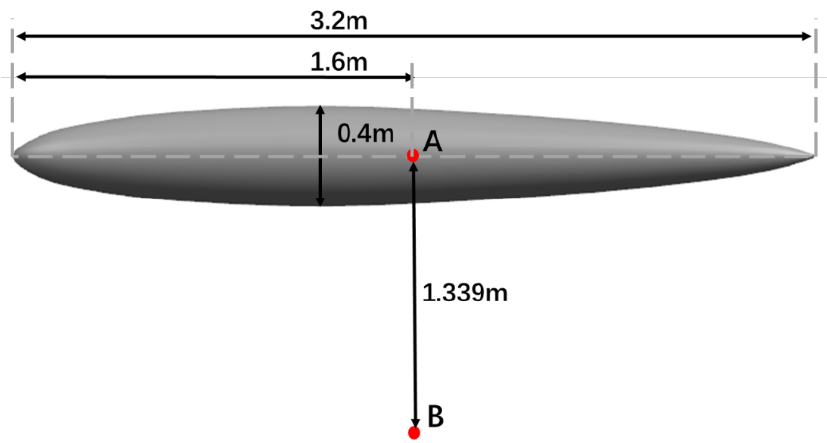
Figure 1. Geometry of the Albacore underwater vehicle model.